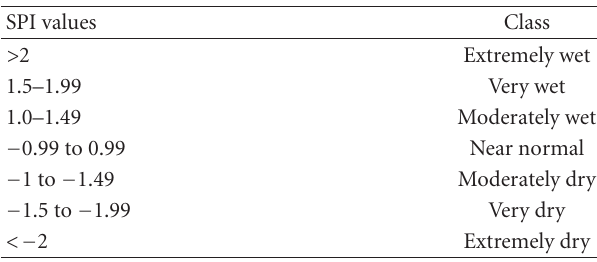
Table 1: Drought classification based on SPI [6].